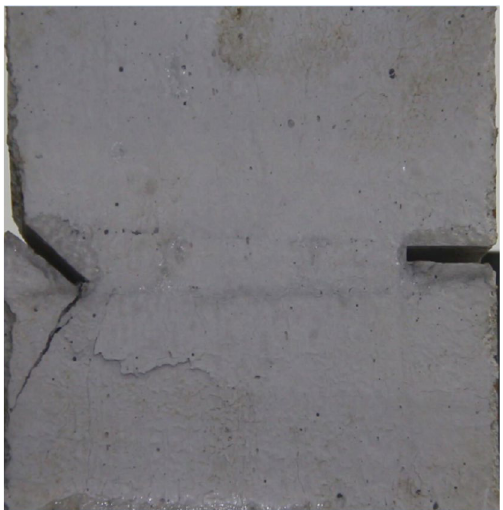
Figure 10. Photograph of a specimen showing transverse shear crack appearing.